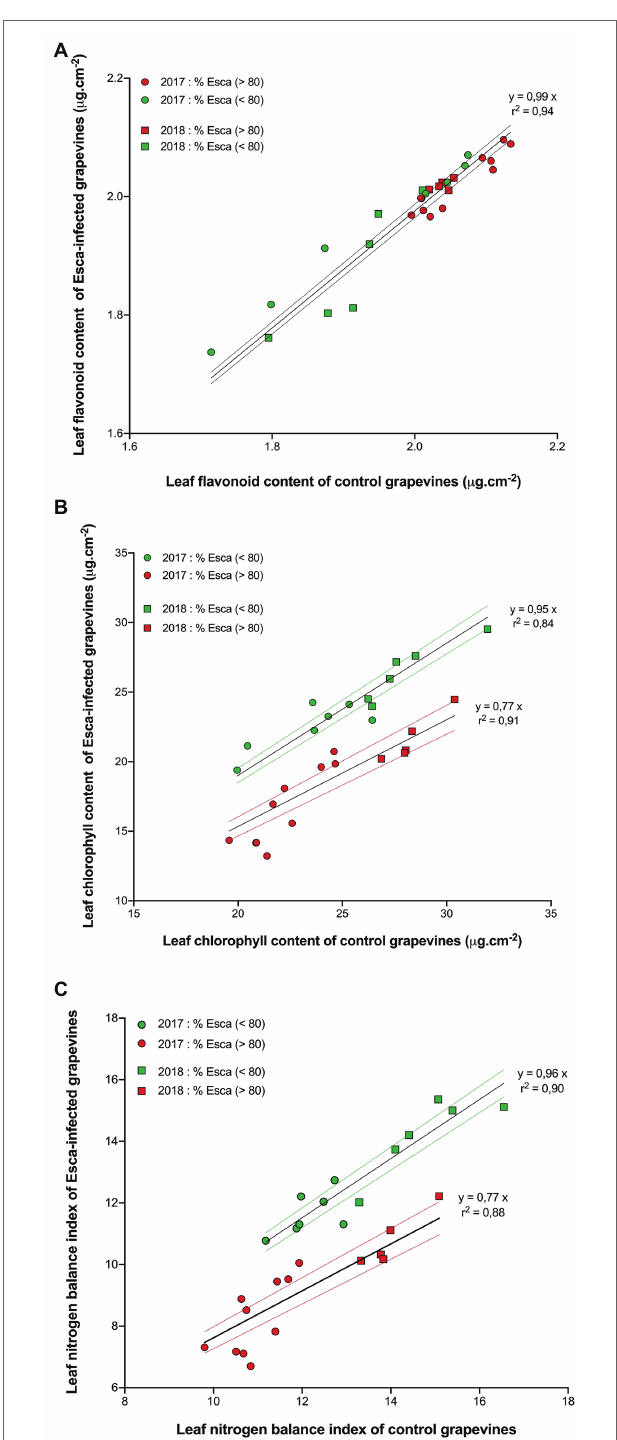
FIGURE 6 | Responses of (A) leaf flavonoid (B) chlorophyll content, and (C) leaf nitrogen index in pre-Esca-symptomatic and Esca-symptomatic leaves in comparison with control (healthy) leaves. Data represent the average of 64 leaves for each modality. Data were separated to reflect days “before” (green symbols) and “after” (red symbols) prevalence of Esca-foliar symptoms reached 80% in 2017 (circles) and 2018 (squares). Regression models (full lines) and a 95% confidence interval (colored-dotted lines) are also